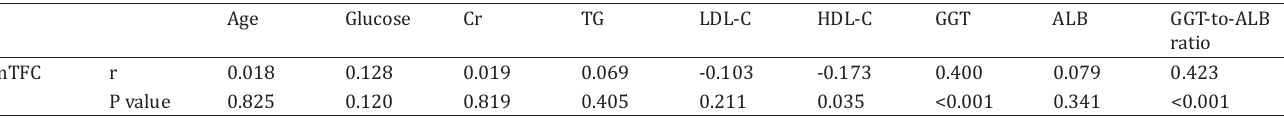
ACE- Angiotensin-converting enzyme; ARB- Angiotensin receptor blocker; COPD- Chronic obstructive pulmonary disease; DM- Diabetes mellitus; GGT- Gamma-glutamyl transferase; HDL-C- High-density lipoprotein cholesterol; HT- Hypertension; LAD- Left anterior descending coronary artery; LCX- Left circumflex artery; LDL-C- Low-density Correlation of mean TFC with variables